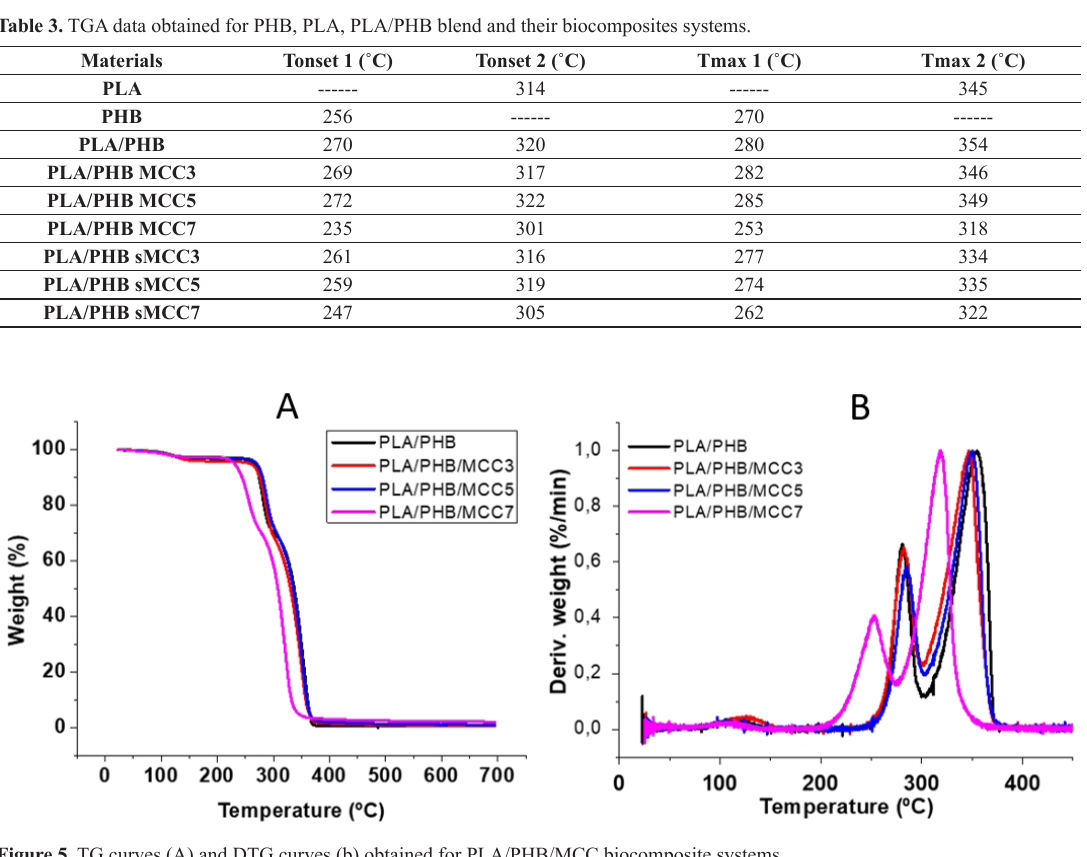
Figure 5. TG curves (A) and DTG curves (b) obtained for PLA/PHB/MCC biocomposite